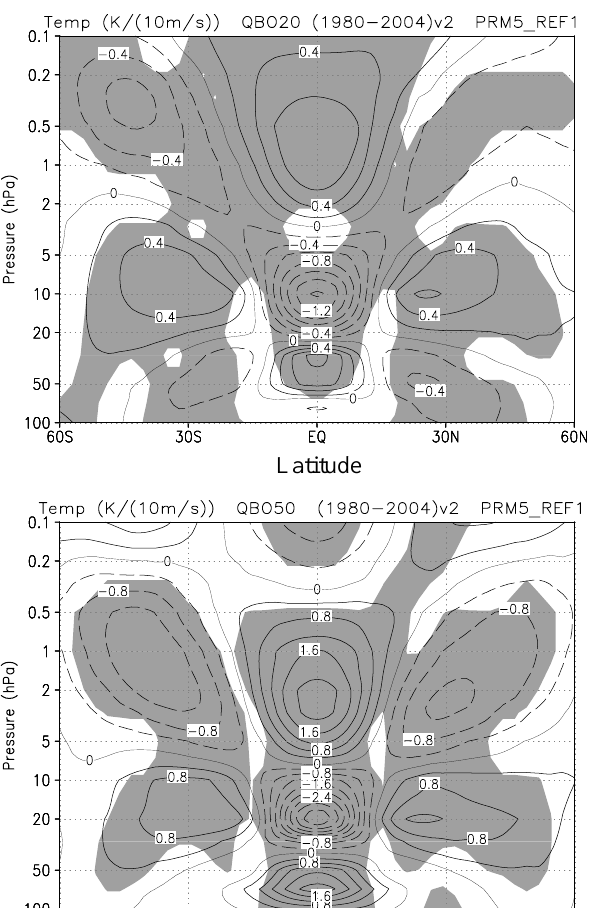
LatitudeLatitude